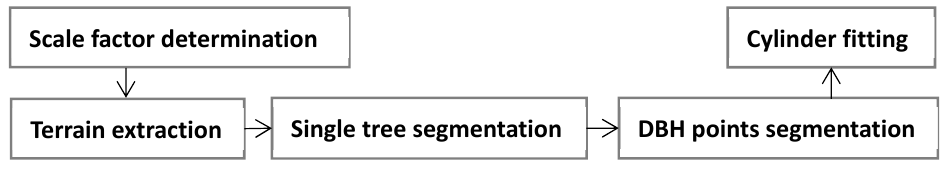
Figure 6. The pipeline of DBH extraction.